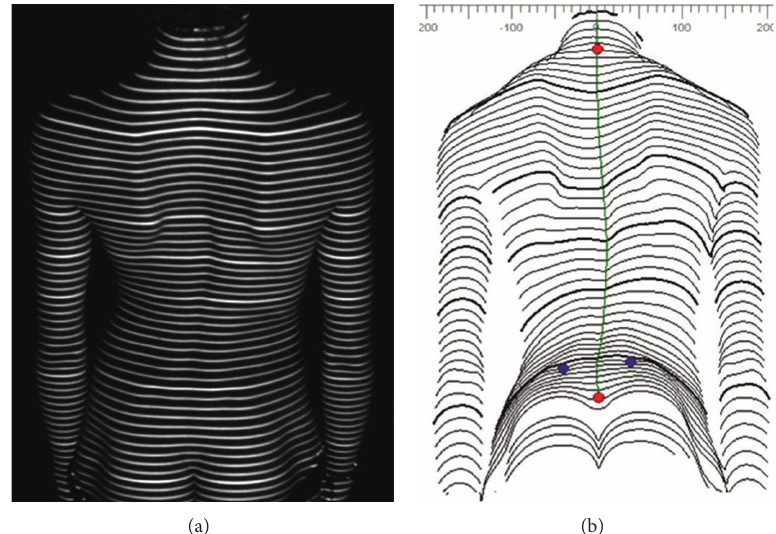
Figure 4: Raster lines projected onto the surface of subject’s back (a) and reproduced computerized surface topography map (b).